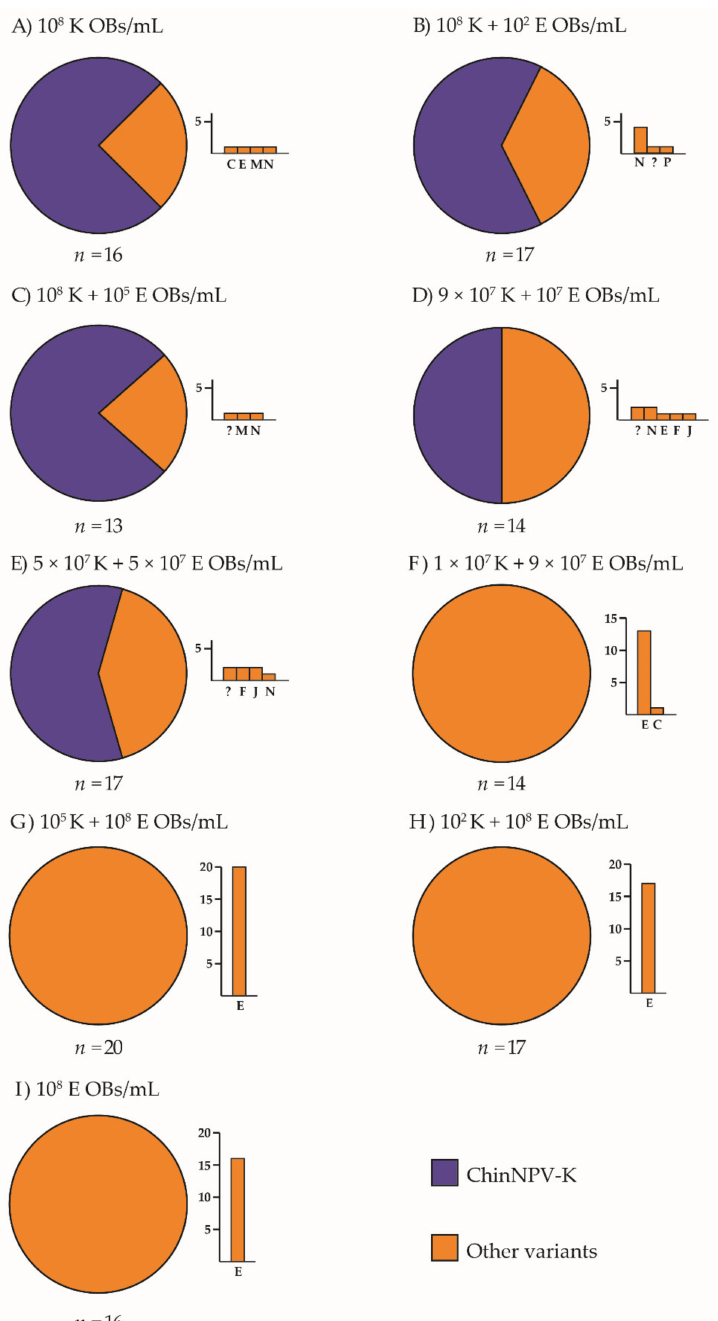
Figure 3. Prevalence of REN profiles in Chrysodeixis includens fifth instar larvae that died follow- ing inoculation of mixtures of variant K OBs and variant E OBs at high inoculum concentration (total concentration 10 8 OBs/mL). Inocula were ( A ) 1 × 10 8 K, ( B ) 10 8 K + 10 2 E, ( C ) 10 8 K + 10 5 E,